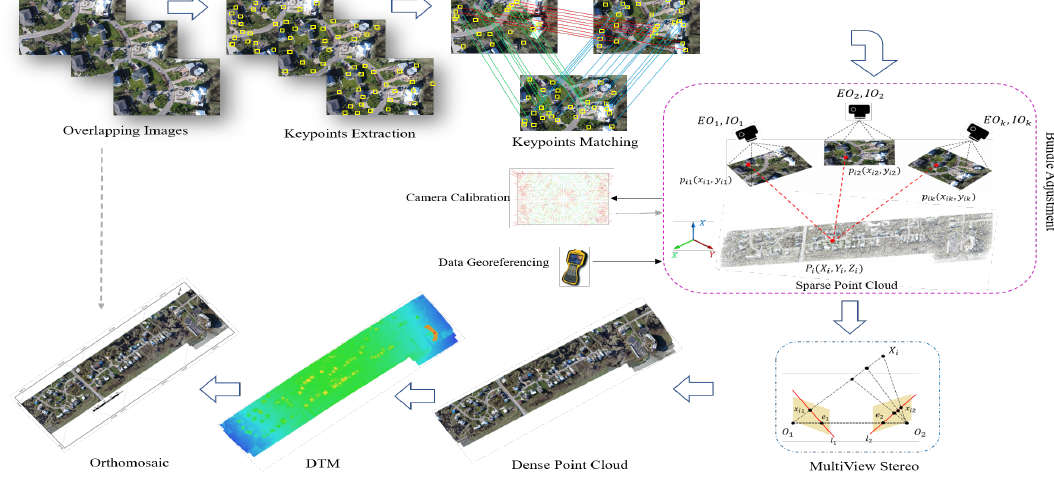
Figure 6. Steps of SfM